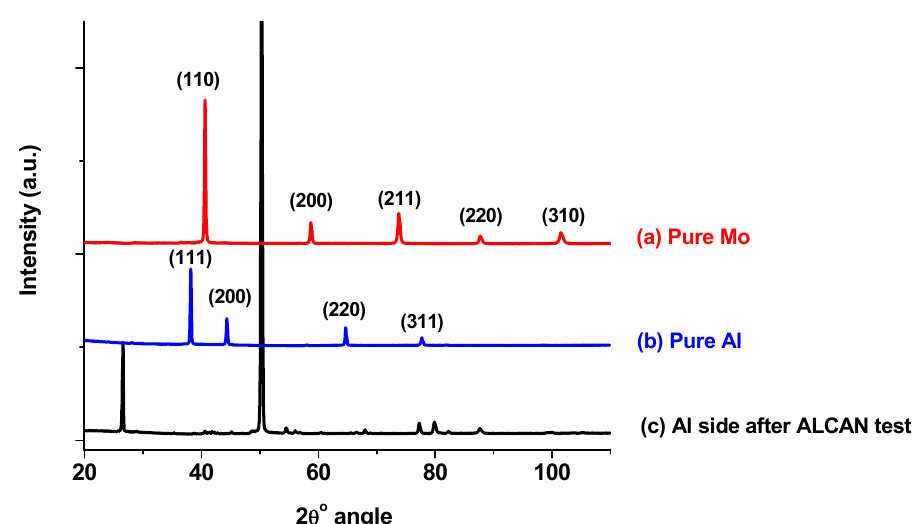
Figure 16. XRD patterns of sample for the bulk ( a ) Mo, ( b ) Al, and ( c ) Al-Mg in close proximity to the Mo block sample after the ALCAN immersion test.